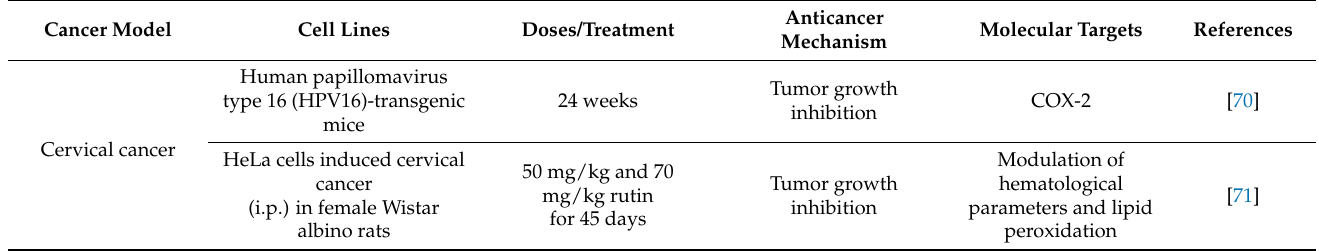
Table 2. In vivo antitumor efficacy of rutin and its mechanisms of